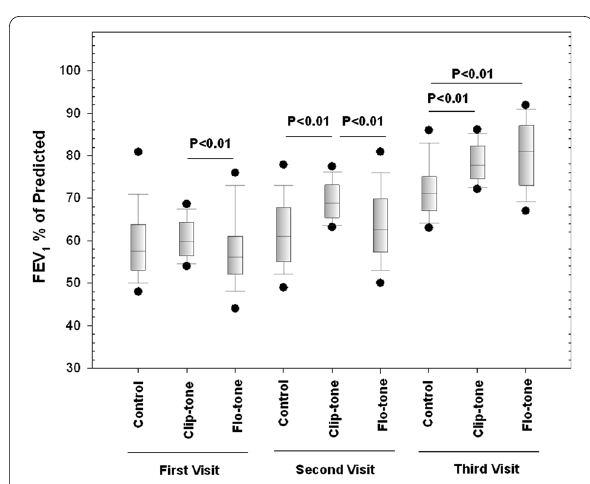
Fig. 4 Comparing medians of FEV1% of predicted of different interventions per